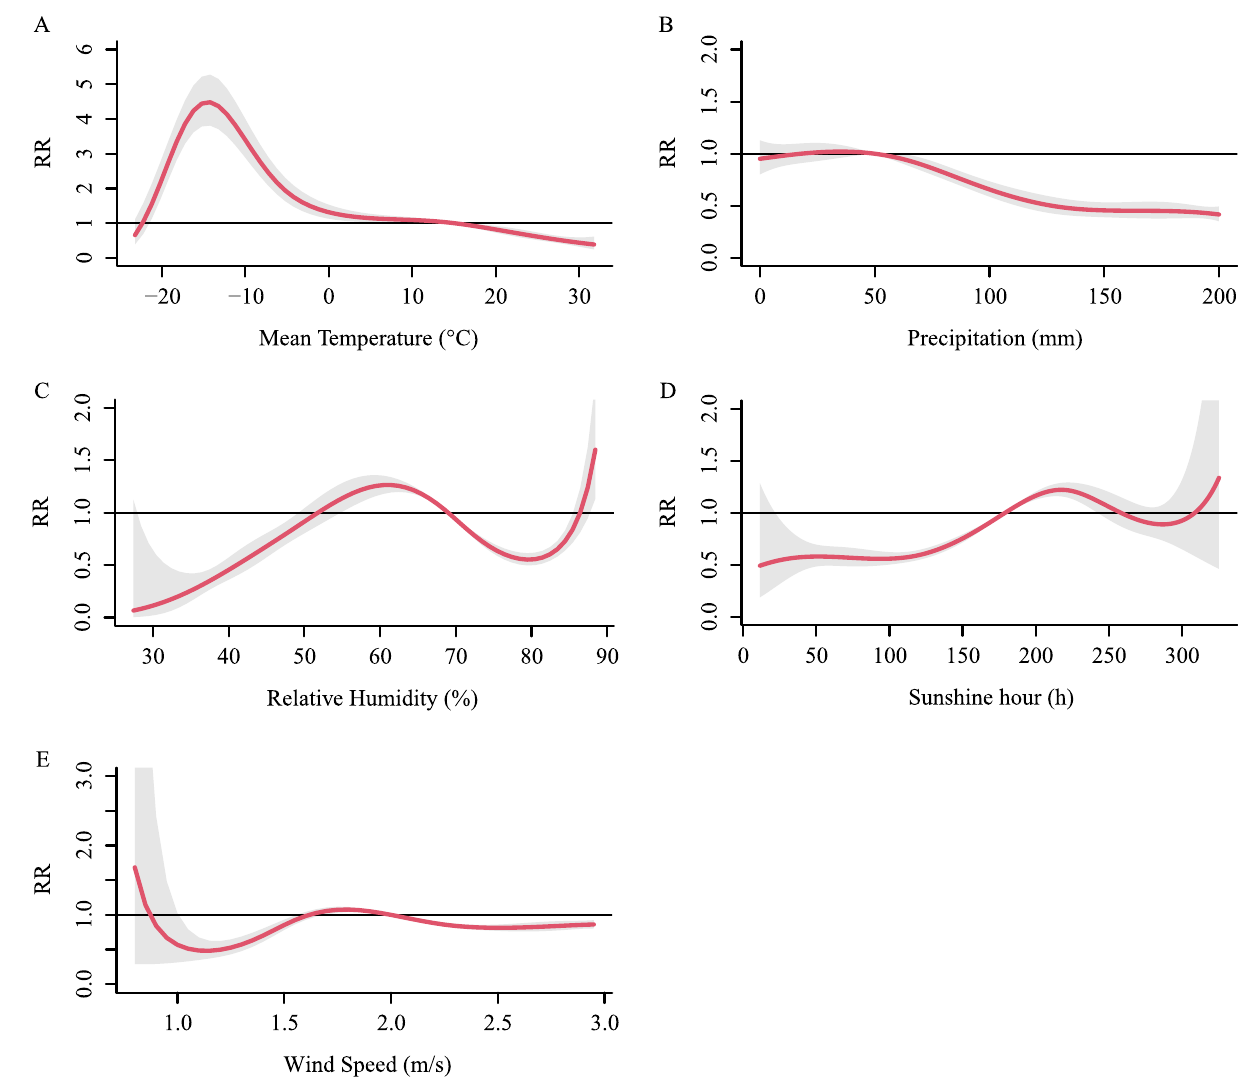
Figure 6. Summary of cumulative exposure–response curves for HFRS incidence with a lag of 0–6 months for meteorological factors from 2004 to 2018 in the univariate model. The Y-axis represents the relative risk of each variable. The x-axis represents the range of observations for each variable. Red lines represent means estimated using the DLNM model, shaded areas represent 95% confidence